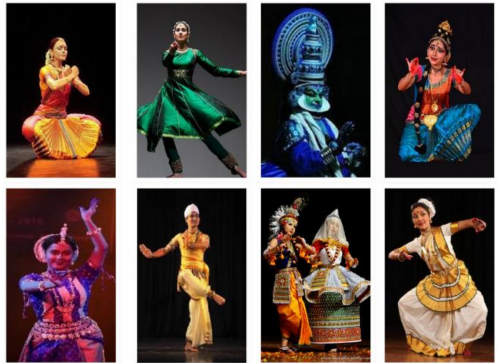
Figure 2. Sample images from the